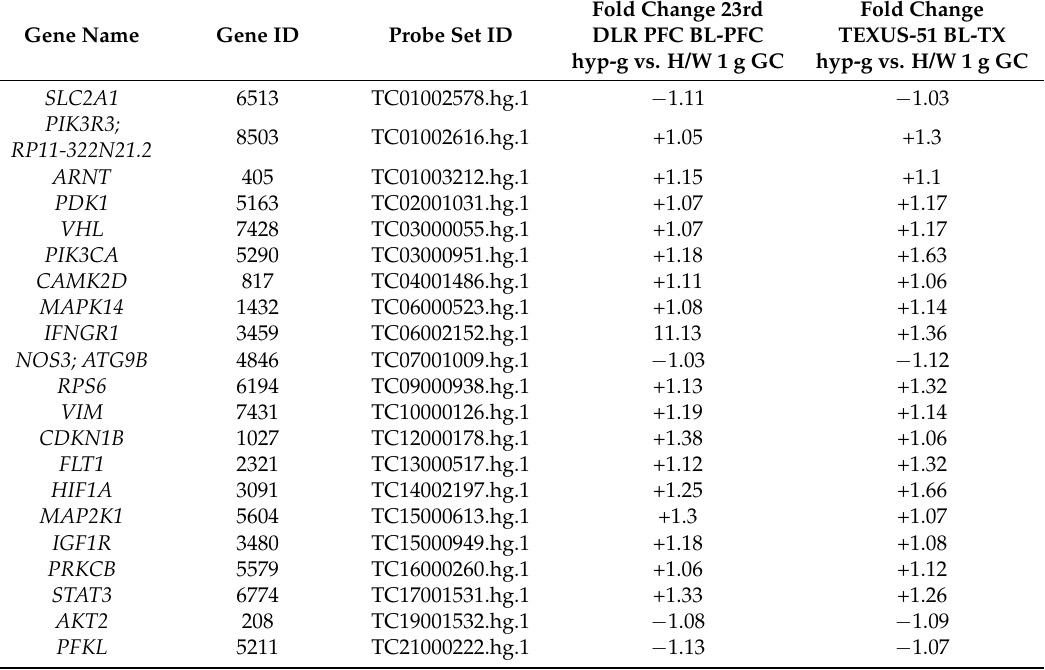
Table 6. Differentially regulated probe sets in a continuous manner in 20 s and 75 s of hypergravity identified in human Jurkat T cells in the 23rd DLR parabolic flight and TEXUS-51 suborbital ballistic rocket campaigns; 21 probe sets, belonging to 21 genes were differentially regulated with respect to both altered gravity platforms. Plus: significantly up-regulated probe sets ( p -value < 0.05), minus: significantly down-regulated probe sets ( p -value < 0.05). FCs are ratios between the averages of linear expression values. If the ratio is <1, FC is calculated as the negative reciprocal of the ratio. For the abbreviations of the group names see Table 1.